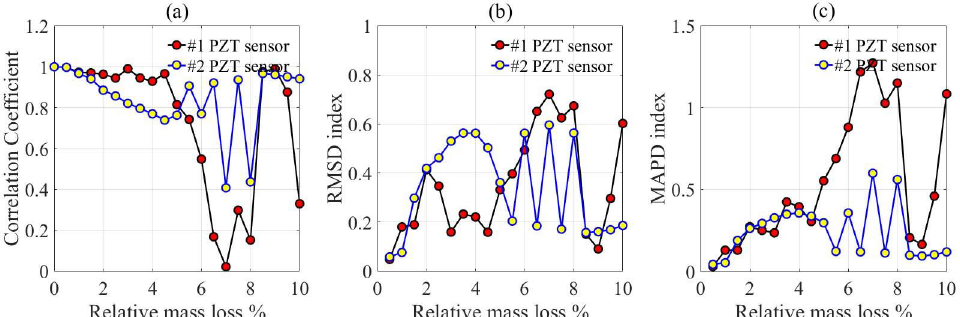
Figure 9. Corrosion indices of PZT transducers in a frequency interval of 150–200 kHz for transducer #1 and 125–175 kHz for transducer #2. ( a ) Correlation Coefficient; ( b ) RMSD index; ( c ) MAPD index.